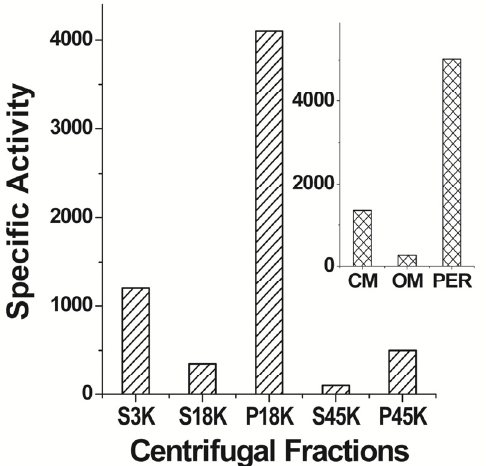
Figure 7. cPHB synthase activity in centrifugal fractions of E. coli BW25113 lysates. S, supernatant; P, pellet. Late log-phase cells were lysed by ultrasonication. The low-speed pellet (P3K) was discarded and the supernatant (S3K) was separated into the following density fractions: envelope fraction (P18K), cytoplasm (S18K), ribosomal fraction (P45K), and cytosolic fraction (S45K). PHB synthase activity was assayed in each fraction by following the conversion of water-soluble 14 C-3-HB-CoA into TCA-insoluble oligomers. Insert shows distribution of activity in P18K fractions (envelope fractions). CM, cytoplasmic membrane; Per, periplasm; OM, outer membrane. Specific activity; counts per minute per mg protein. From Dai and Reusch [47].